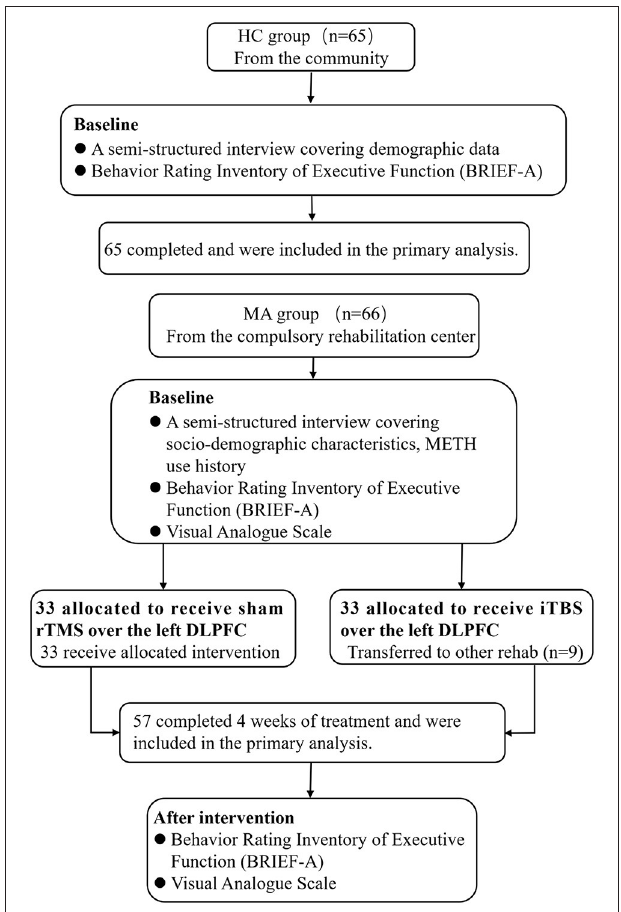
FIGURE 1 | Flowchart of the study. HC, healthy control group; MUD, methamphetamine use disorder; iTBS, intermittent theta burst stimulation.